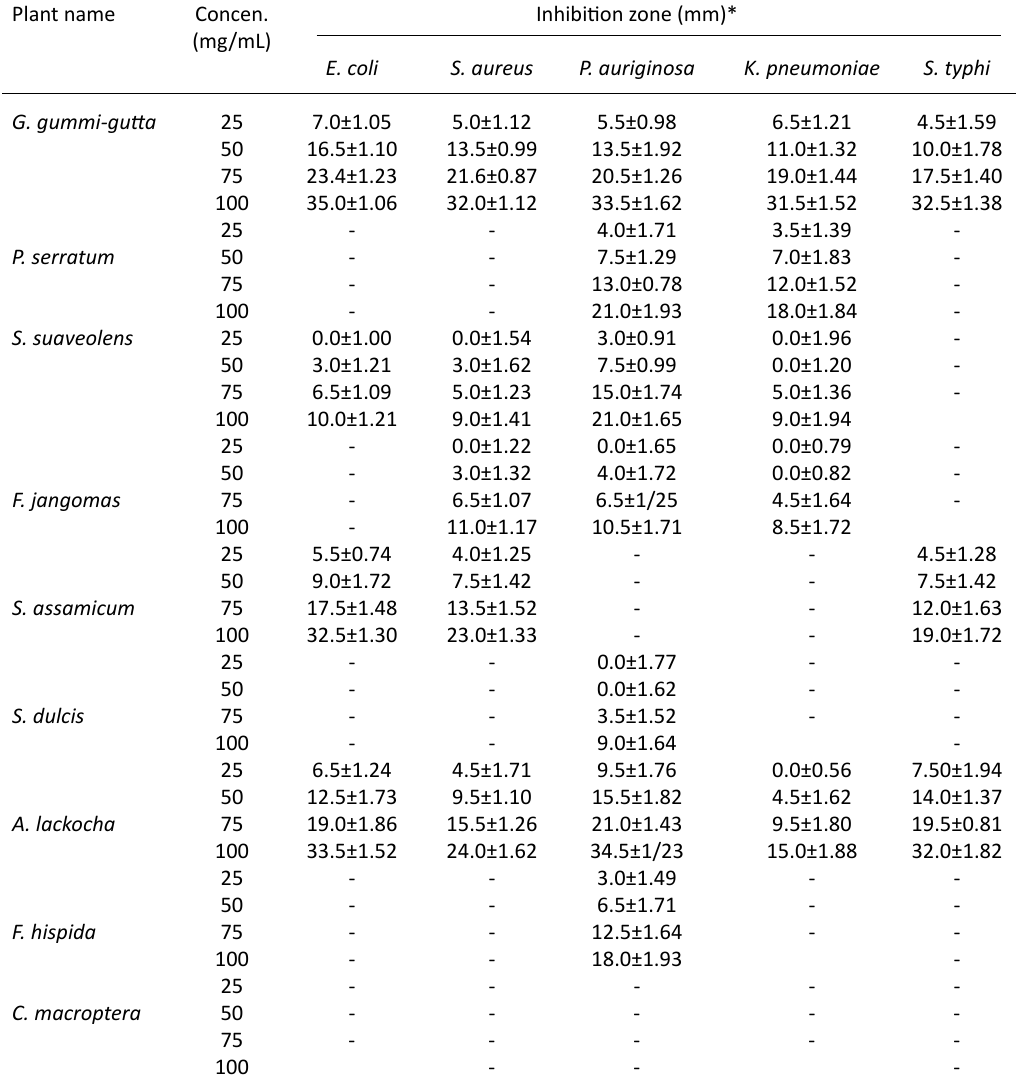
table 2. Antibacterial activity of ethanol extracts of wild fruits against five human bacterial pathogens Plant name